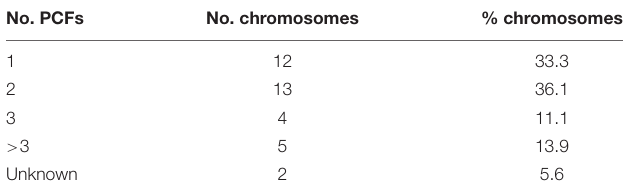
TABLE 2 | Verification of putatively chimeric scaffolds by PCR. TABLE 3 | Number of PCFs per camel chromosome.